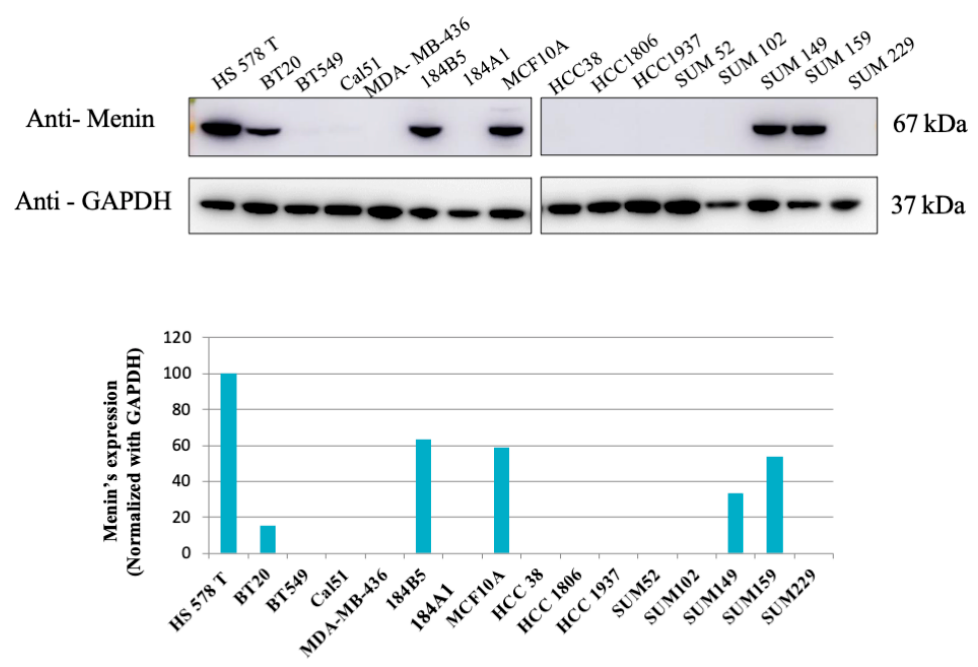
Figure 1. Western blot analysis of Menin expression in 16 TNBC cell lines. The expression of menin in 16 TNBC (triple-negative breast cancer) cell lines were evaluated using WB analyses . Six out of sixteen cell lines displayed menin’s expression, and Hs 578T had the highest level of menin. Bands were quantified by densitometry and menin was normalized to GAPDH levels.